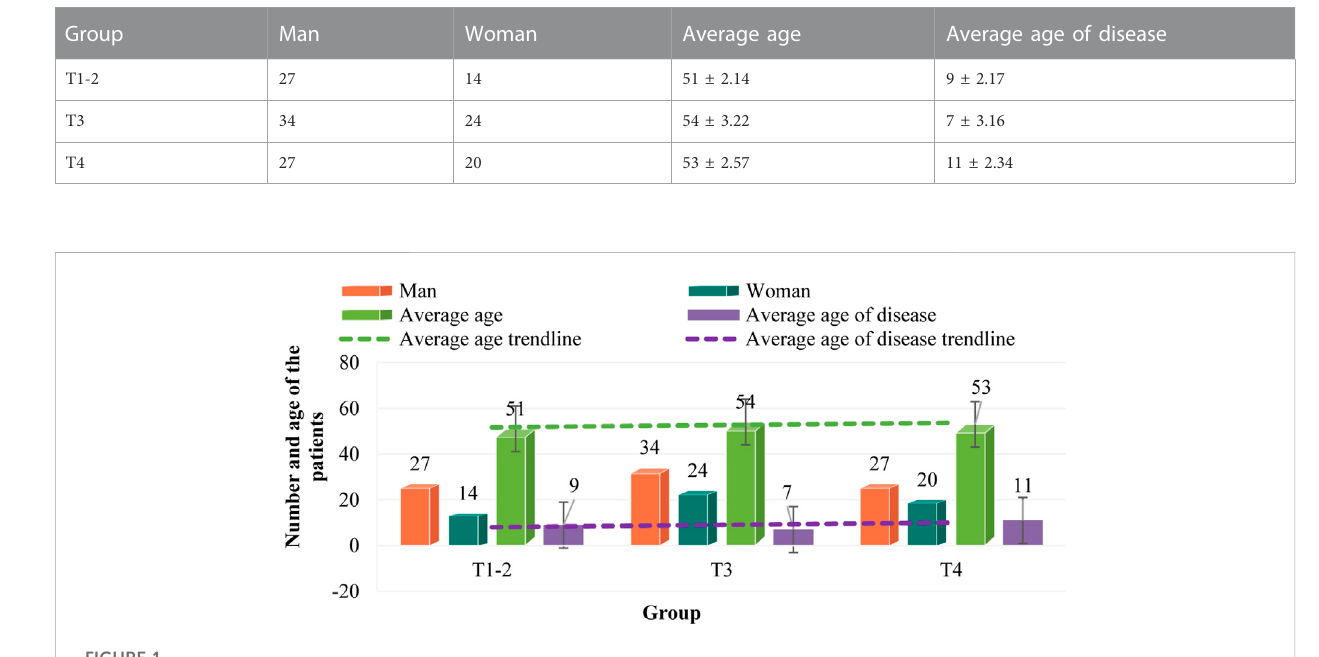
TABLE 1 General information of patients.